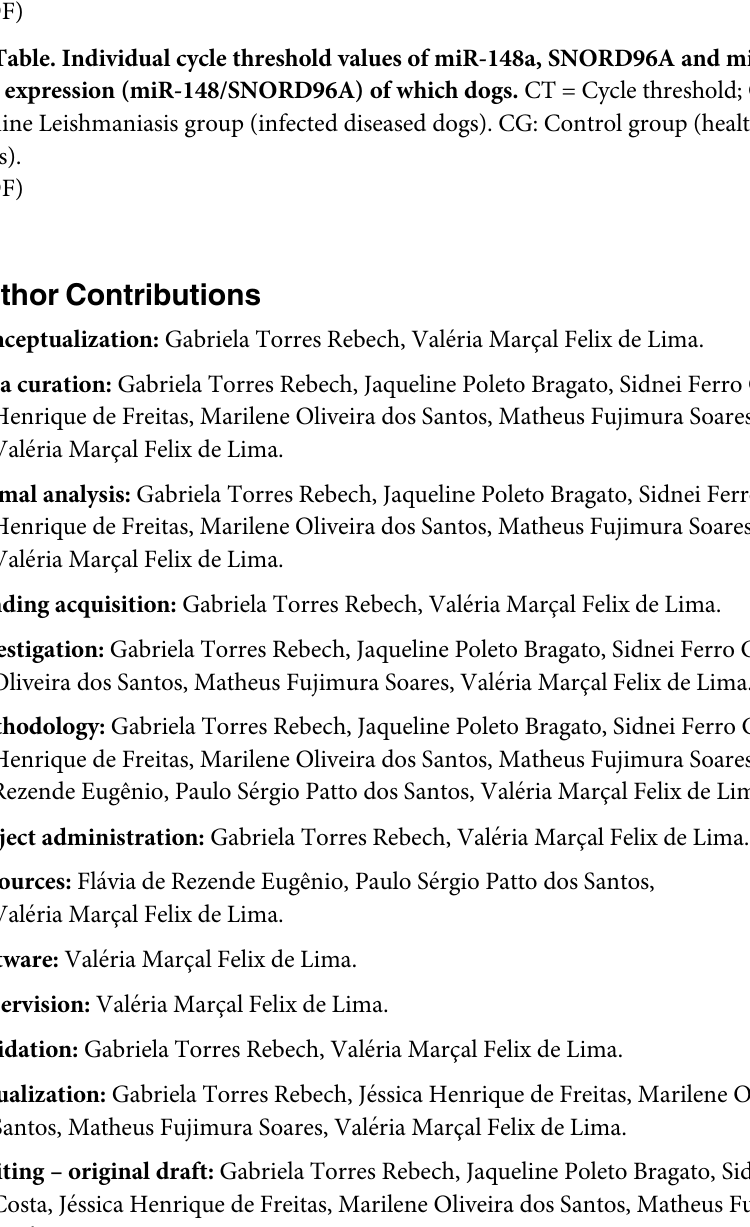
S3 Table. Red blood cell parameters of CanL and control groups. CanL: Canine Leishmania- sis. Control: healthy negative control. RBC: red blood cells, MCV: mean corpuscular, MCHC: mean corpuscular hemoglobin concentration volume. � Reference value. S4 Table. White blood cells and platelet counts of CanL and control groups. CanL: Canine Leishmaniasis. Control: healthy negative control. � Reference values. S5 Table. Cycle threshold values of curve. Standard curve parameters: Slope -3.372; Y-Inter- cept 28.57; Efficiency 0.98; R^2 0.955. S6 Table. Individual cycle threshold values of miR-148a, SNORD96A and miR-148a rela- tive expression (miR-148/SNORD96A) of which dogs. CT = Cycle threshold; CanL = CanL: Canine Leishmaniasis group (infected diseased dogs). CG: Control group (healthy uninfected